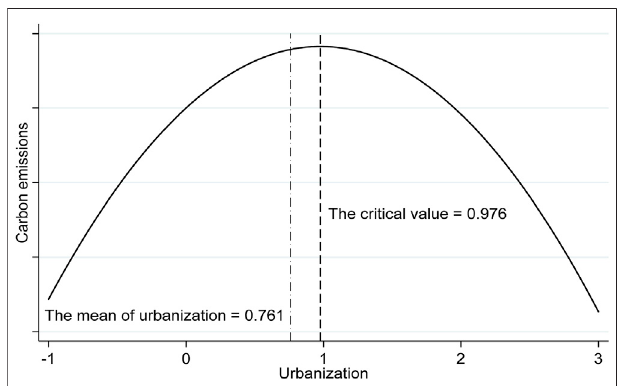
FIGURE 3 | The nonlinear associations between urbanization and carbon